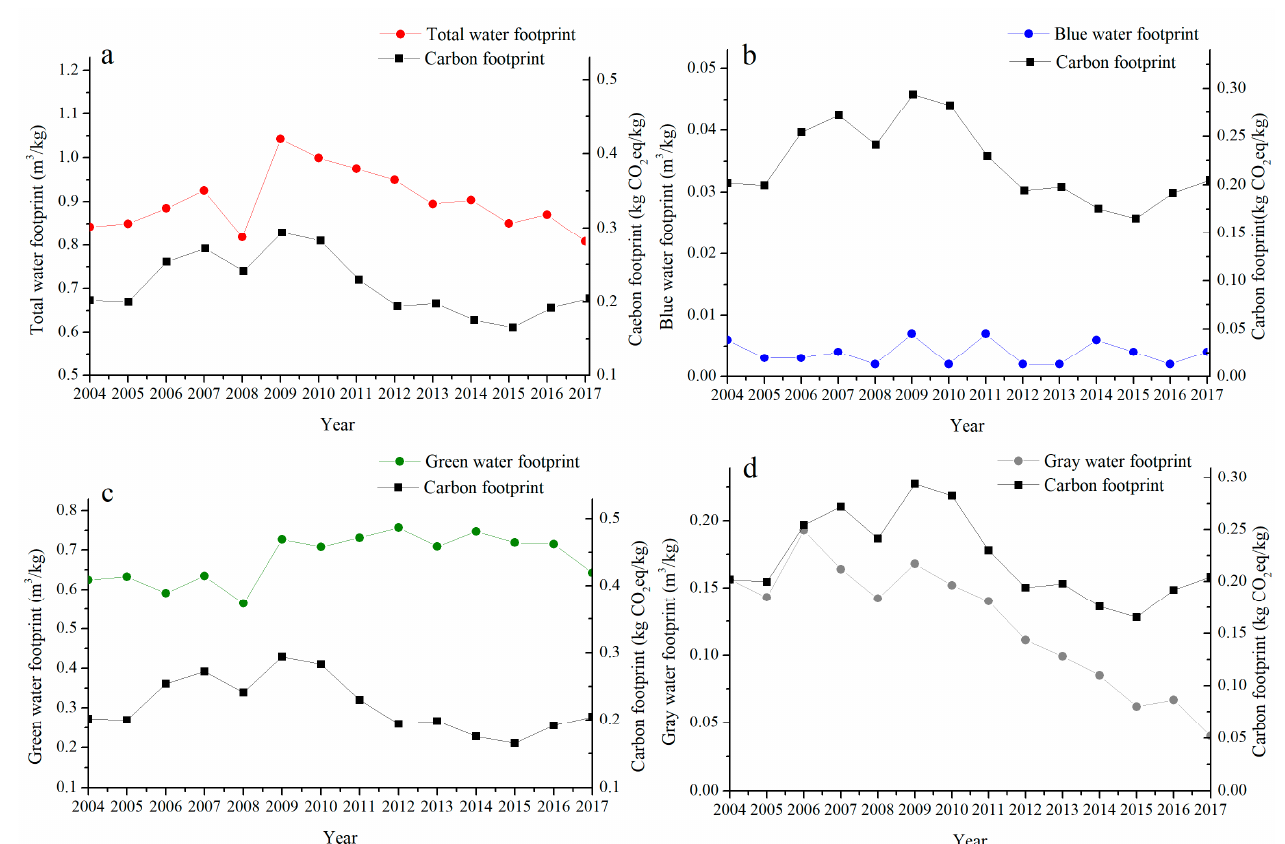
Figure 10. Relationships between the time series of the CF and the WF: ( a ) the CF and the total WF; ( b ) the CF and the blue WF; ( c ) the CF and the green WF; ( d ) the CF and the gray WF.